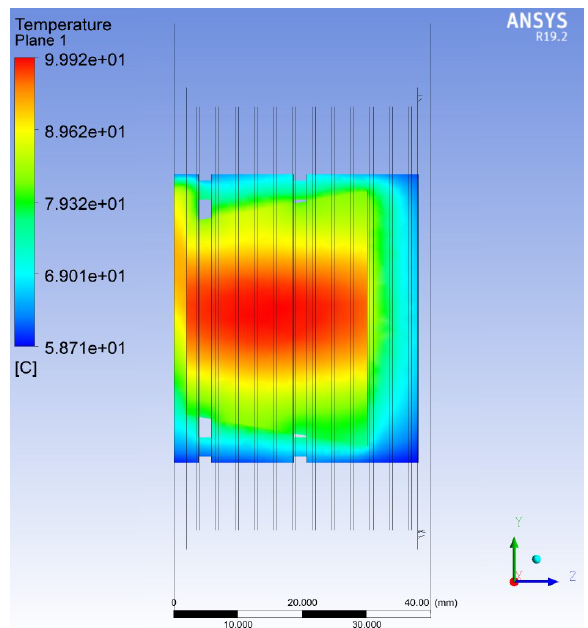
Fig. 10. Temperature map of the Be and Galinstan of a preliminary ANSYS model of CoolGal with water coolant for 700 W (10  A current of 70 MeV protons). The maximum temperature of the Be component is 100°C.